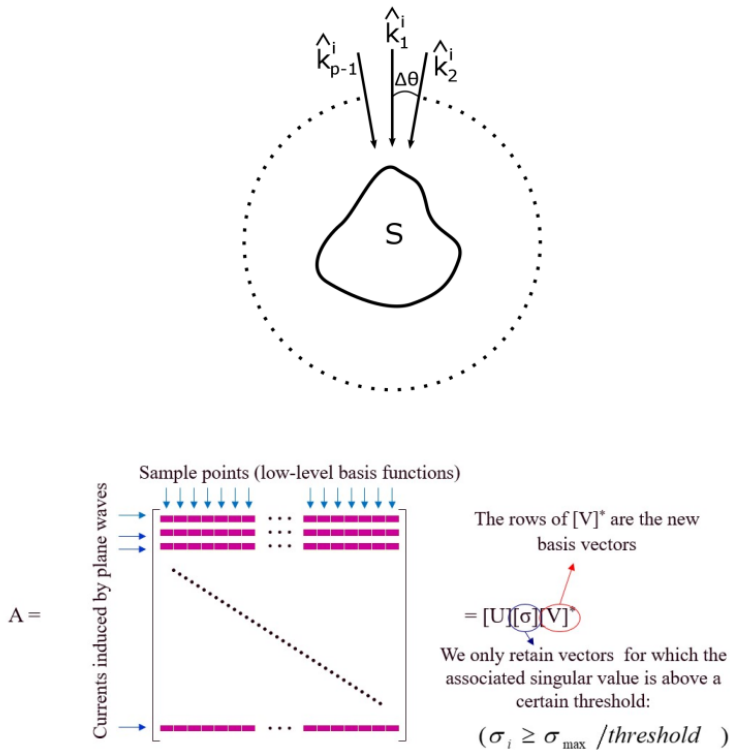
Figure 3. Scheme illustrating the procedure followed for the generation of the CBFs (charac-teristic basis functions).